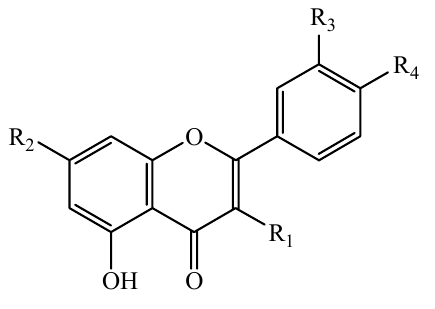
Figure 1. Chemical structures of compounds 1 - 7